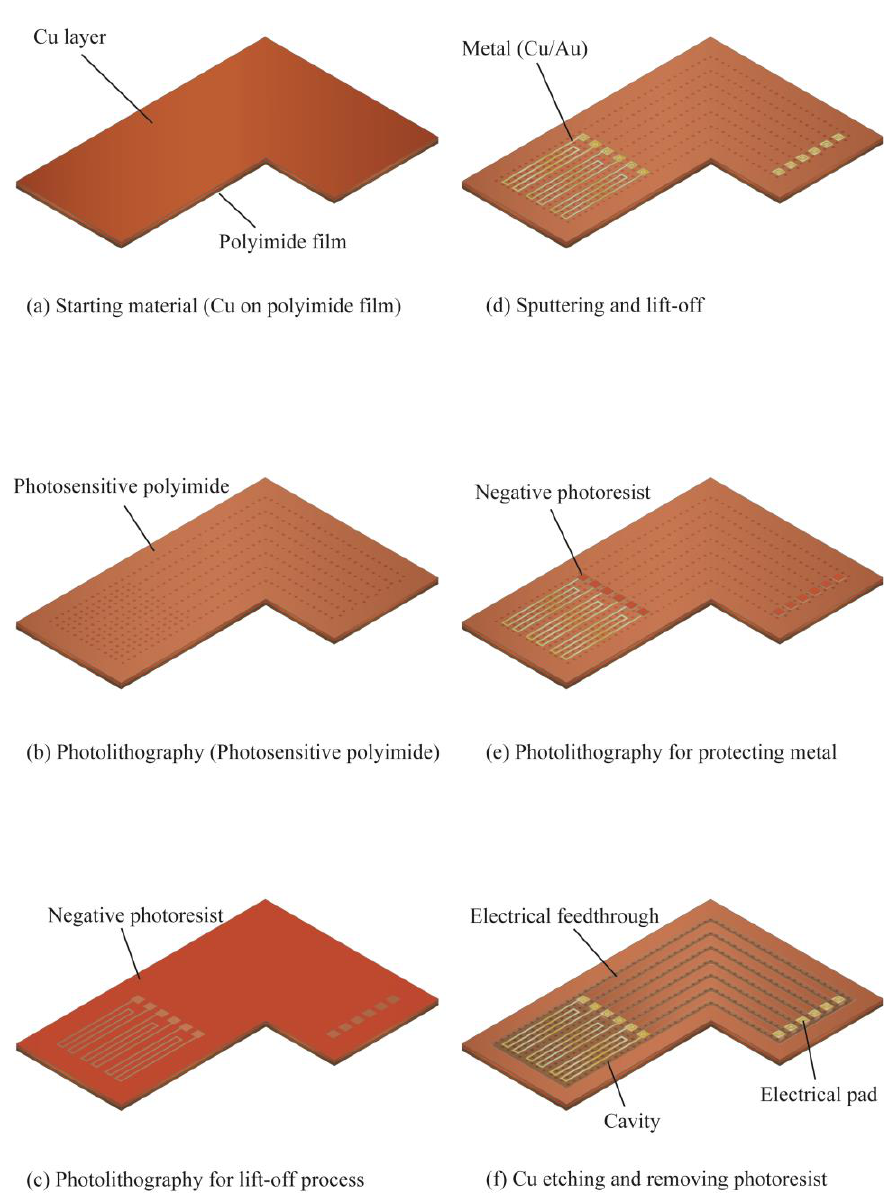
Figure 7. Fabrication process for sensing element on a COP substrate.